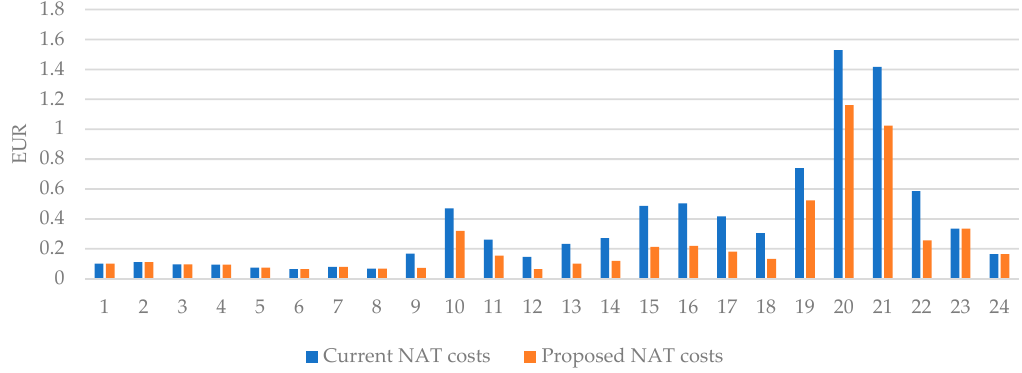
Figure 9. Comparison between the sum of hourly NAT costs for a 3-period Time-of-Use rate (27.6– 41.4 kVA) in a BaU scenario and in the proposed business model during the 6-month trial period. Source: Authors’ own elaboration.